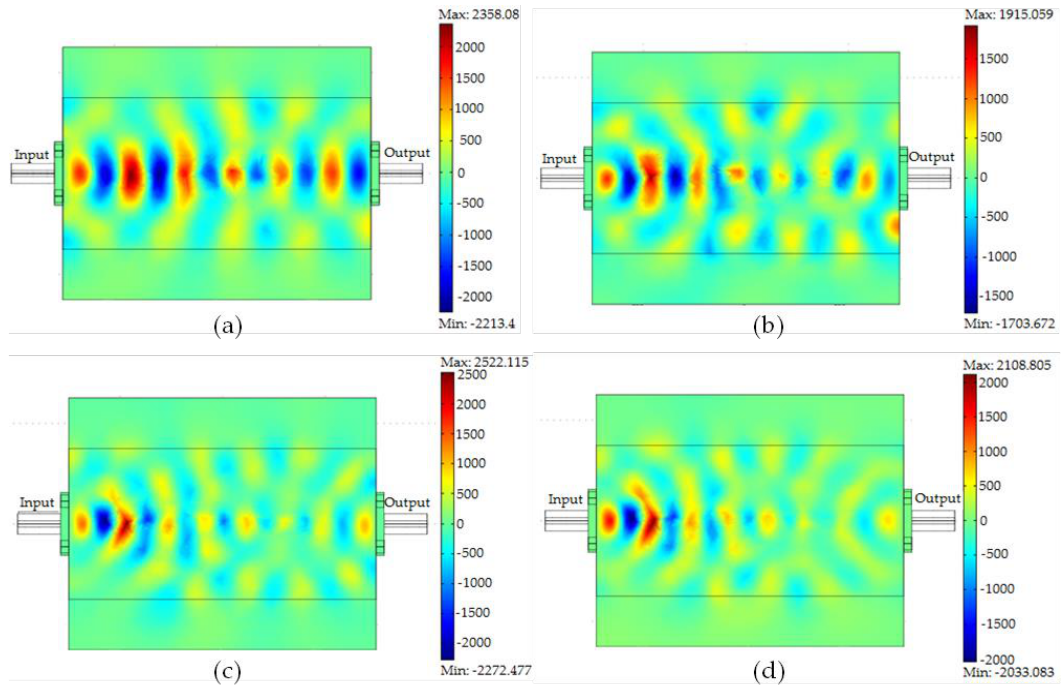
Figure 11. |S 21 | (dB) for different recycled α -Fe 2 O 3 particles as a function of frequency .